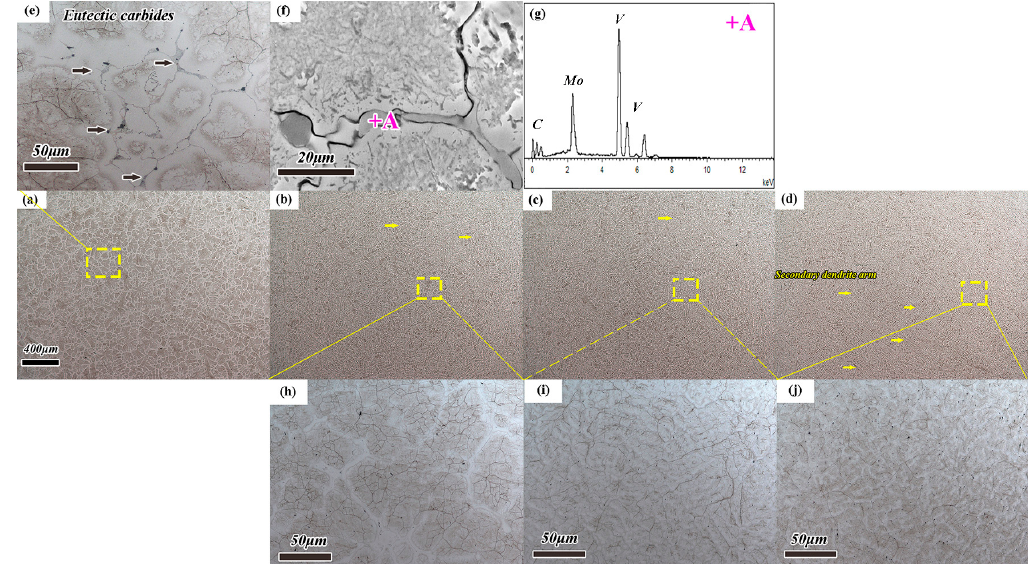
Figure 1. Metallographic and SEM micrographs of the specimens as-casted: ( a ) Metallographic observations in 0RE; ( b ) Metallographic observations in 0.018RE; ( c ) Metallographic observations in 0.048RE; ( d ) Metallographic observations in 0.15RE; ( e ) Metallographic observations in 0RE; ( f ) SEM micrographs in 0RE; ( g ) Energy dispersive spectrometer (EDS) analysis of eutectic carbides at A region in ( f ); ( h ) Metallographic observations in 0.018RE; ( i ) Metallographic observations in 0.048RE and ( j ) Metallographic observations in 0.15RE.